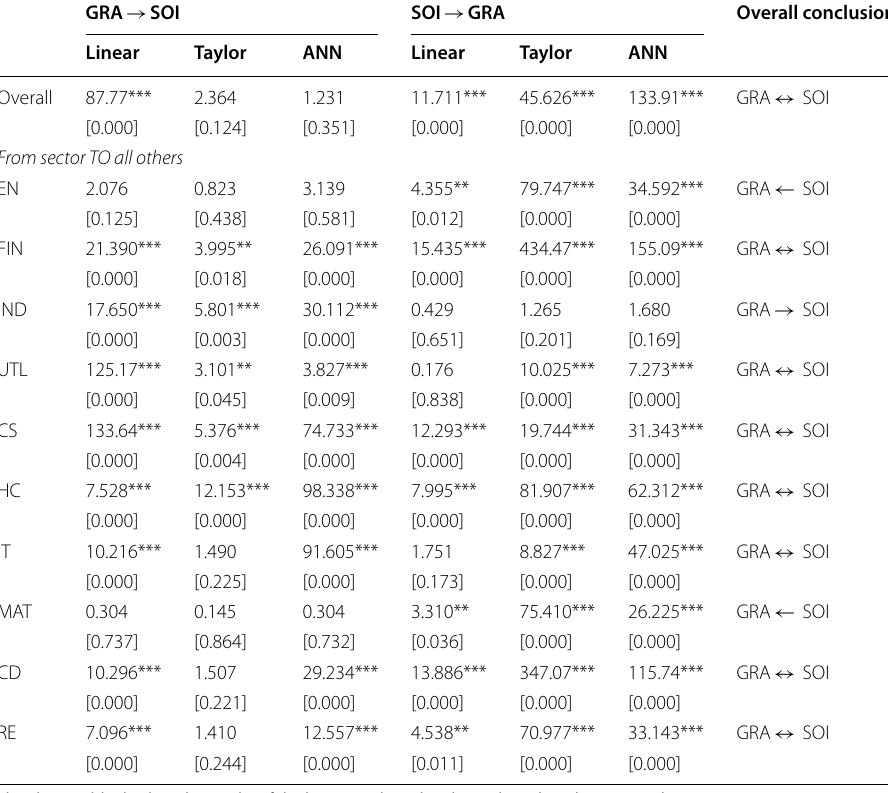
The above table displays the results of the linear, Tor‑based and ANN‑based nonlinear causality